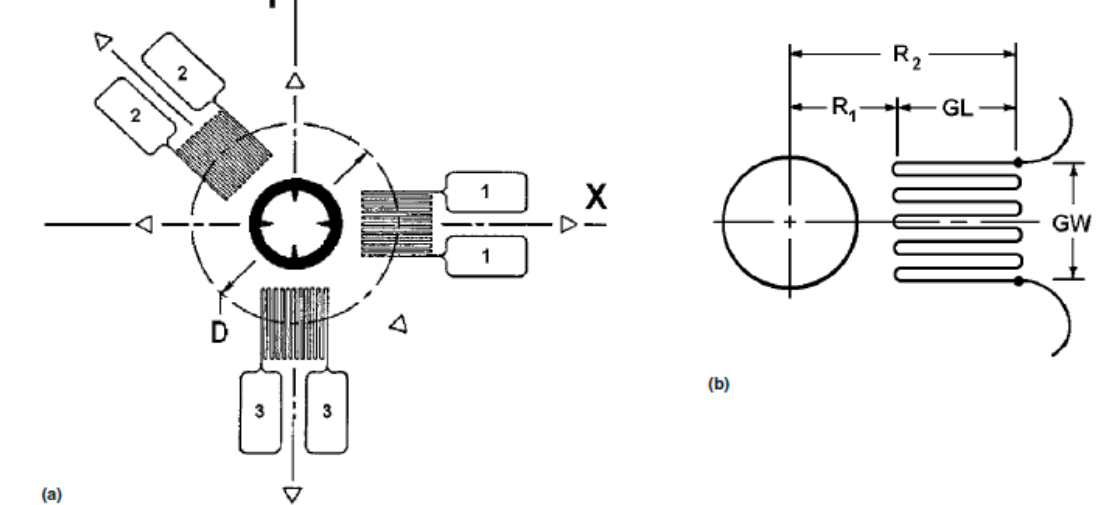
Table 1. Strain gauge rosette dimensions in mm; D: diameter gauge circle; GL: length gridlines; GW: